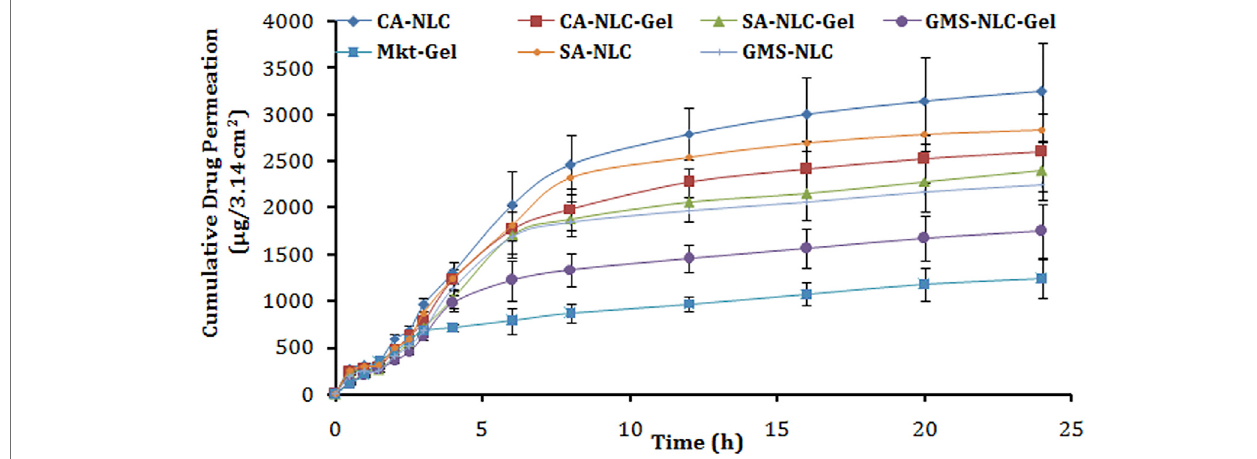
FIGURE 6 | Cumulative drug permeation/e x vivo skin permeation analysis of different gel formulations tested (CA-NLC, SA-NLC, SA-NLC-gel, GMS-NLC, CA- NLC-gel, GMS-NLC-gel, and Mkt-gel).